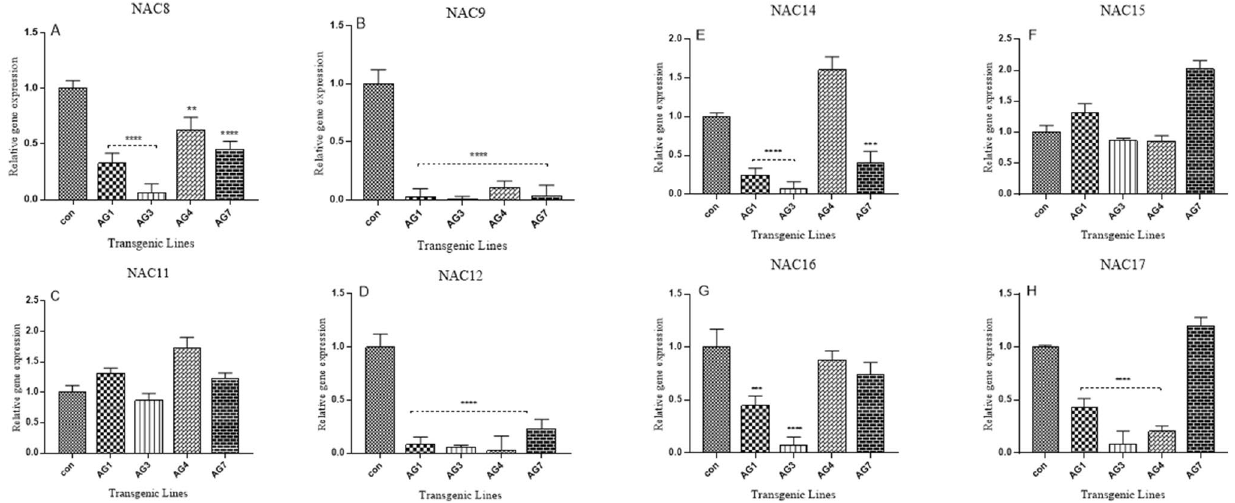
Figure 4. Relative expression of NAC genes ( A ) GhNAC8 ( B ) GhNAC9 ( C ) GhNAC11 ( D ) Gh NAC12 ( E ) GhNAC14 ( F ) GhNAC15 ( G ) GhNAC16 ( H ) GhNAC17 in AGL42 transgenic lines All values represent the average of technical and biological triplicate. Asterisks indicate significant difference “**** P -value ≤ 0.0001; *** P ≤ 0.001; ** P -value ≤ 0.01 through one-way